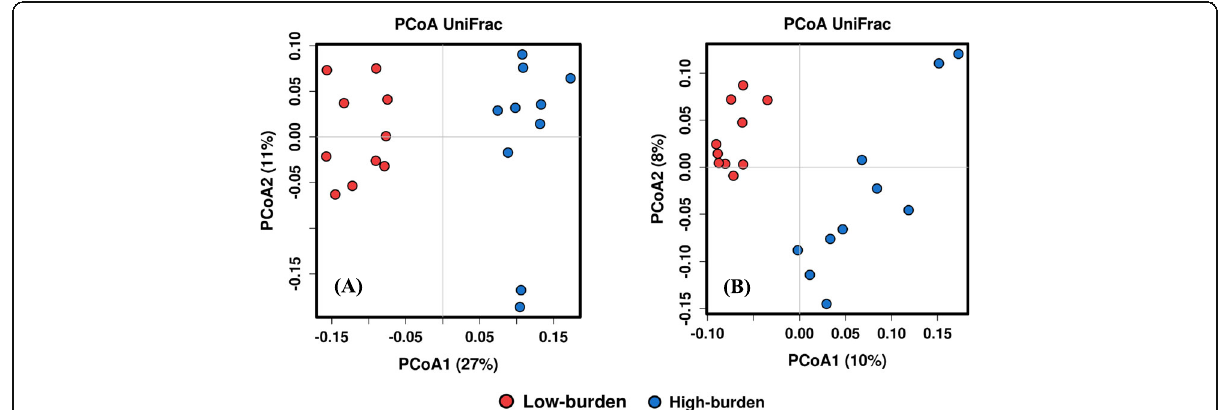
Fig. 2 Distinct clustering of microbiome between high and low worm burden sheep using 16S data. PCoA plot of sheep based on weighted UniFrac ( a ) and un-weighted UniFrac ( b ) distance of faecal microbial composition. Each symbol represents an individual sheep